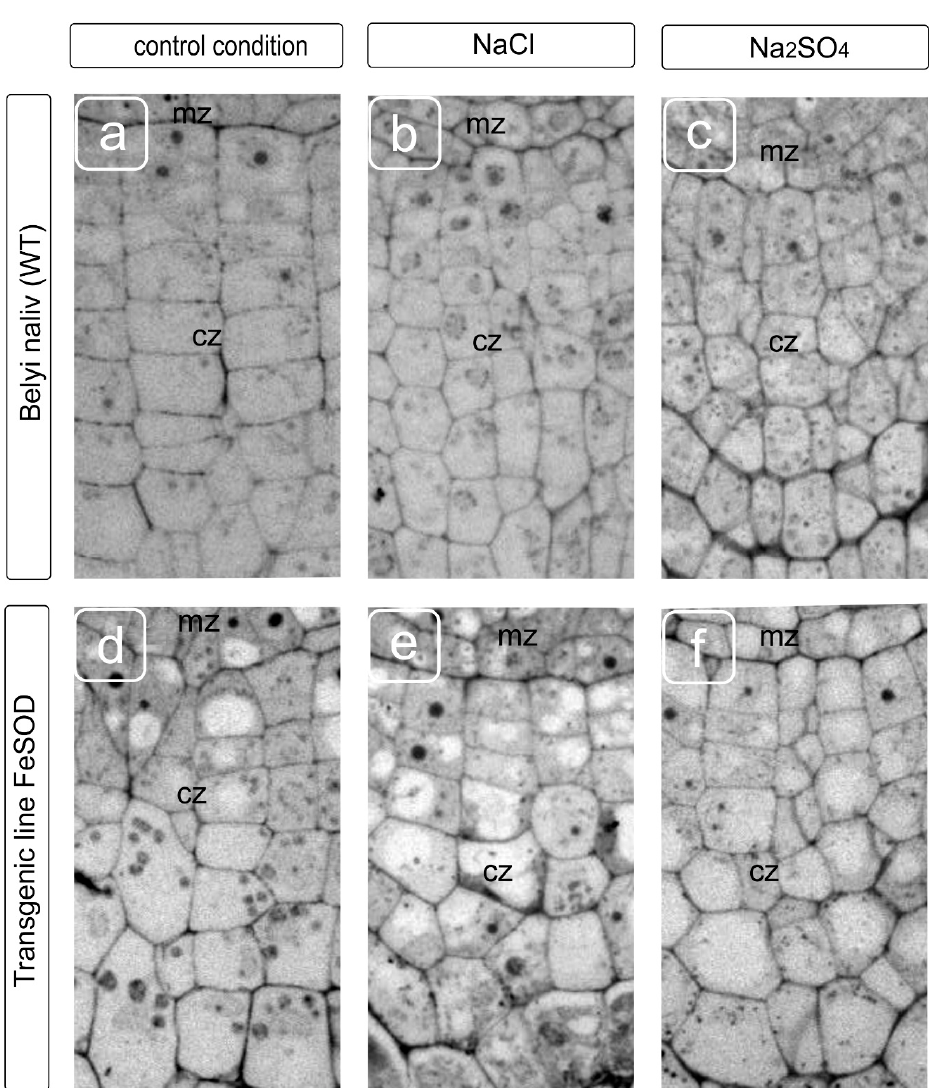
Figure 2. Fragments of transverse sections of root tips showing the zone of cap initials forming apex columella from WT ( a – c ) and transgenic tomato ( d – f ) plants grown without ( a , d ), and supplemented with the NaCl ( b , e ) and Na 2 SO 4 ( c , f ). Modification of the cell walls of root apical meristem and cap cells of the tomato root tip is shown. The thickness and location of adjacent layers related to the cap initials, the transformation of the size and shape are visible as the most sensitive targets for salts treatments. Symbols: mz–meristem zone; cz–columella zone.